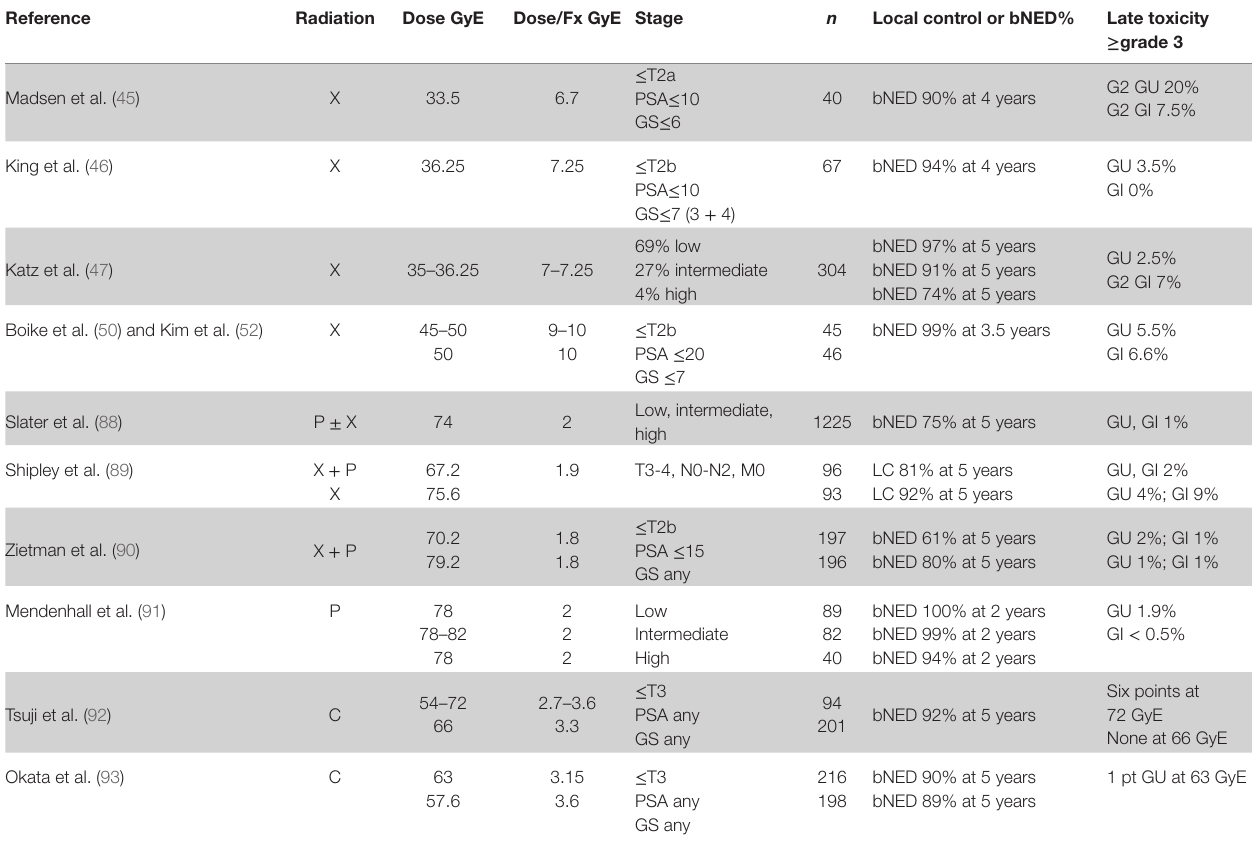
TABLe 4 | Prostate